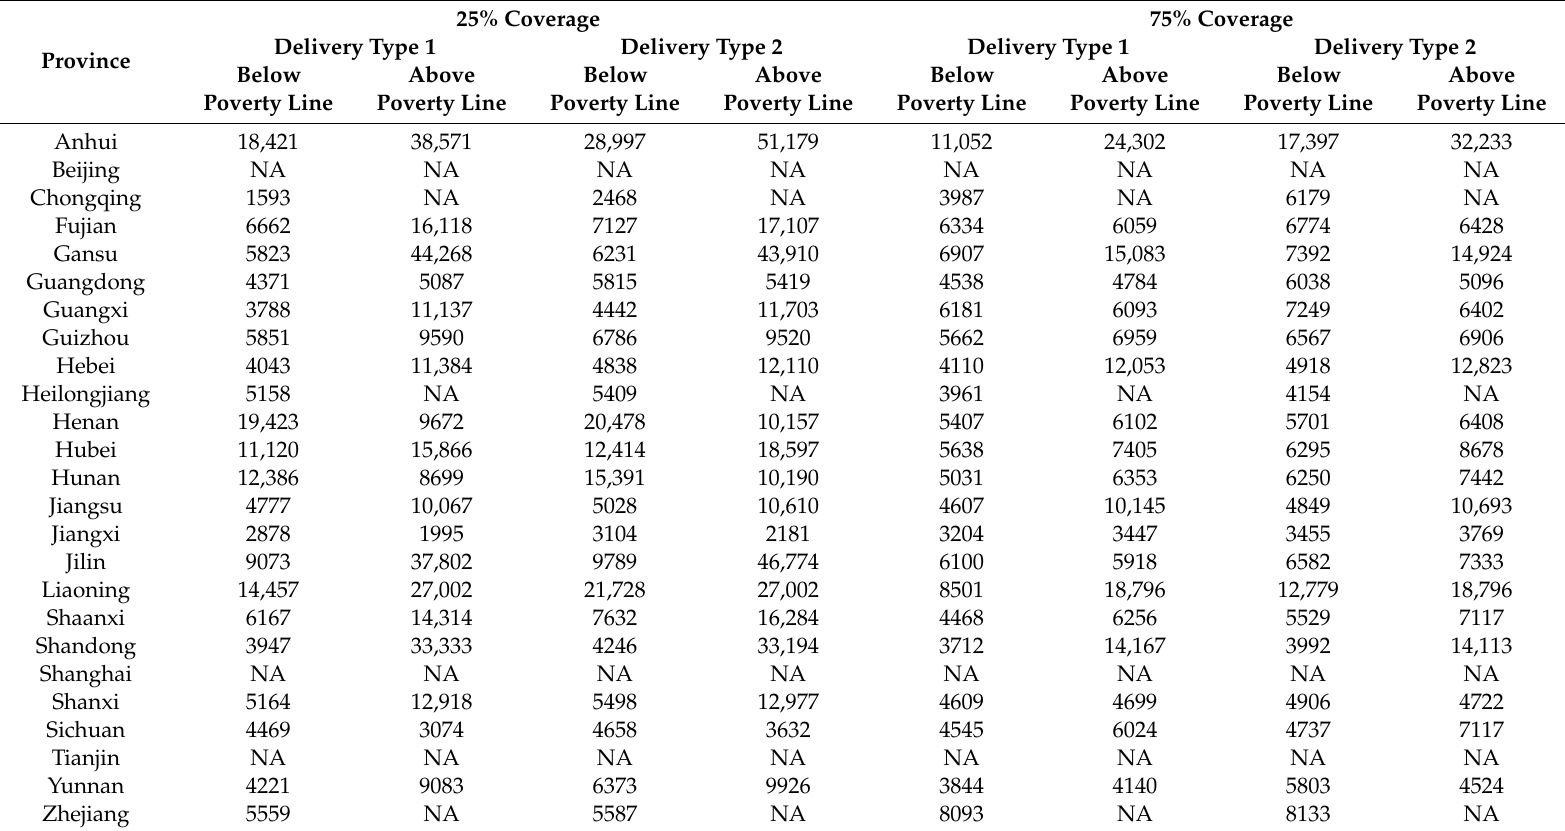
Table 3. Cost-e ff ectiveness of YYB program, by province and poverty status, when the e ff ect size of YYB is halved (Cost (¥) per stunting case averted).